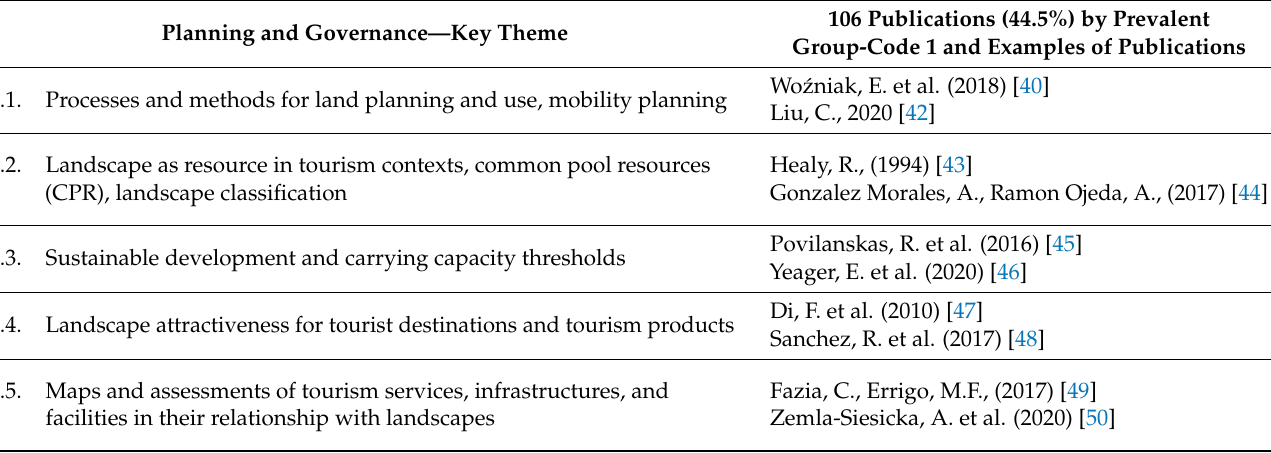
Table 3. Group-Code 1—Number of articles by prevalent key theme and examples of publications. Planning and Governance—Key